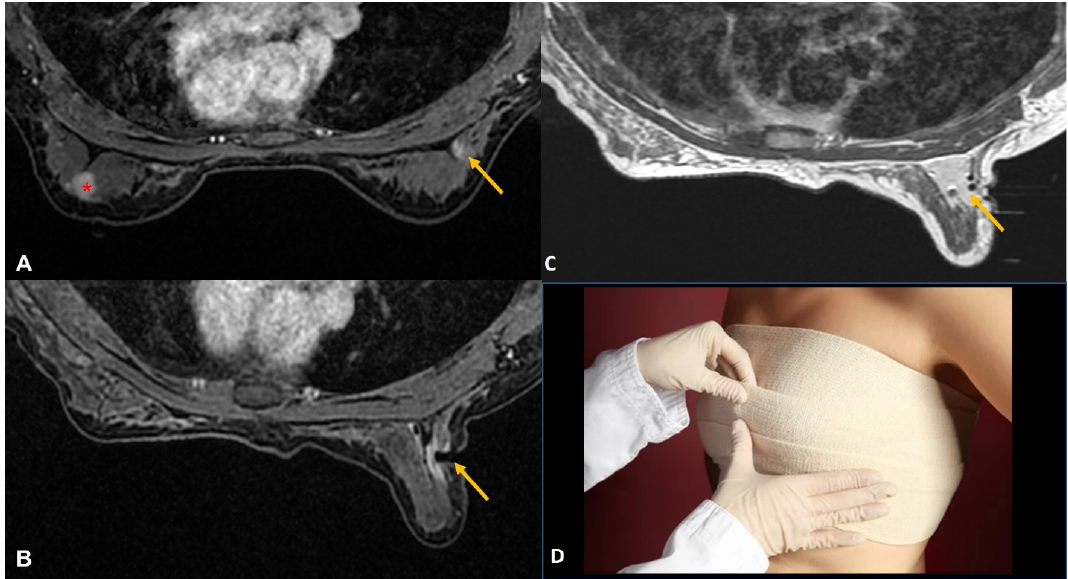
Figure 2. ( A ). Staging MRI in a woman with known left breast cancer (red asterisk) showed focal non-mass enhancement in the right breast (yellow arrow). ( B ). MRI-guided biopsy to rule out contralateral synchronous cancer showed the tip of the obturator at the right location (yellow arrow). ( C ). Post-biopsy non-fat saturated image showed a large hematoma at the biopsy site almost occupying the upper outer quadrant (yellow arrow). ( D ). Tight compression bandage applied to the breast after the biopsy reduces the risk of further bleeding significantly. patients on anticoagulation therapy post-MRI-guided biopsies [19,20], there may still be a risk of hematoma formation due to the large sample size and, hence, whenever possible, the anti-coagulant therapy should be withheld during the procedure time. On the other hand, it is important to understand that, for any reason, if anticoagulant therapy cannot be stopped in a patient needing an MRI-guided biopsy, one can proceed with the biopsy with added precautionary measures. This is more so in a patient with an INR within the therapeutic range within two weeks of the procedure [21]. Therefore, checking the patient’s International Normalized Ratio (INR) prior to the biopsy day may be helpful. Depending on the INR, discussions with clinicians can be made to consider continuing, withholding, or bridging blood thinners if the patient cannot be off anticoagulant therapy [22]. When possi- ble, stopping anticoagulant medicine for at least 5–7 days before the biopsy reduces the bleeding risk. Overall, these contraindications should be evaluated with the radiologist be- fore the scheduled MRI biopsy day, and one must follow institutional guidelines. (d) Small Breasts (Figure 3): This is a common issue in this part of the world, with a cup size of A or AA encountered in nearly a third of patients. Small breasts pose a chal- lenge when the mid to posterior part of the breast does not fall into the grid. Adequate care taken while positioning the patient can contribute significantly to procedural success. Removing the chest pad from the coil allows more posterior breast tissue to fall into the grid. In addition, tilting the patient into an oblique position allows lesions in the posterior breast to fall into a more accessible location for biopsy. Using a Petit needle or half-aper- ture size needle with extra cores can be used in a thin breast with borderline thickness to avoid injury to the skin or chest wall.